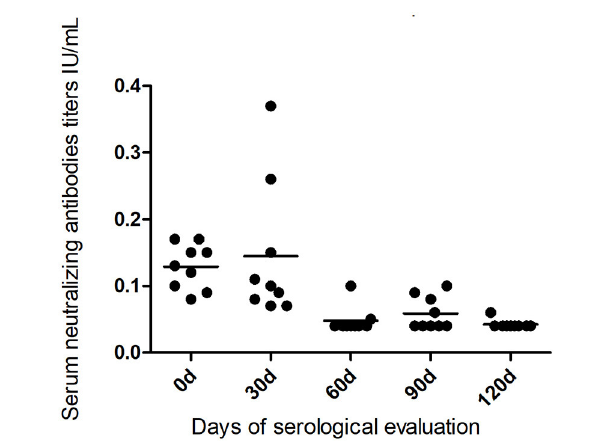
FIGURE 3 | Serological profile of virus-neutralizing antibodies in the bats kept in captivity for 120 days from the studied municipalities.